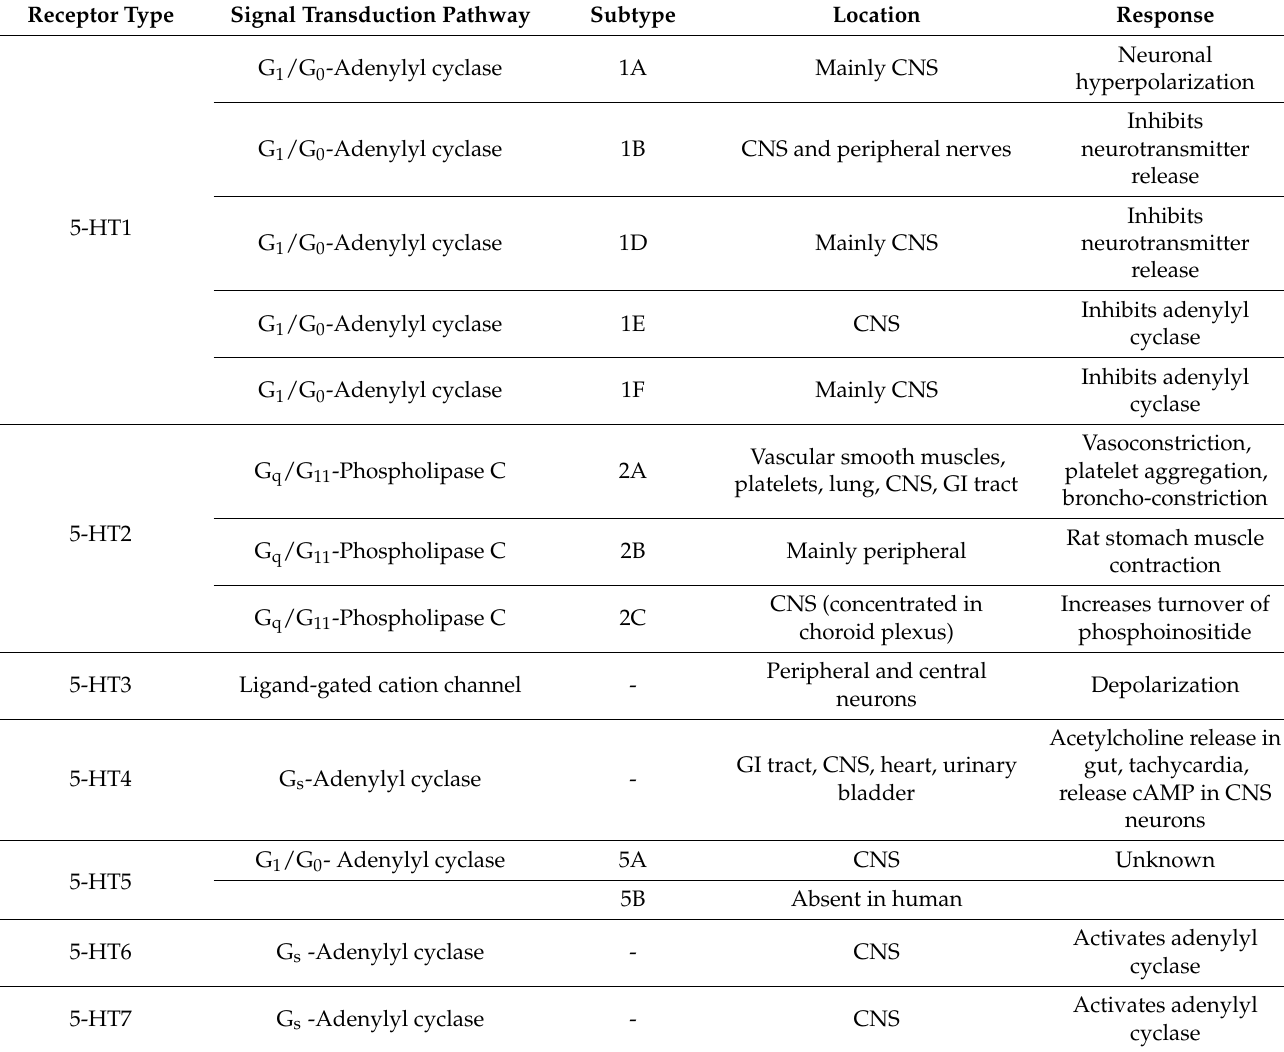
Table 1. Serotonin receptor